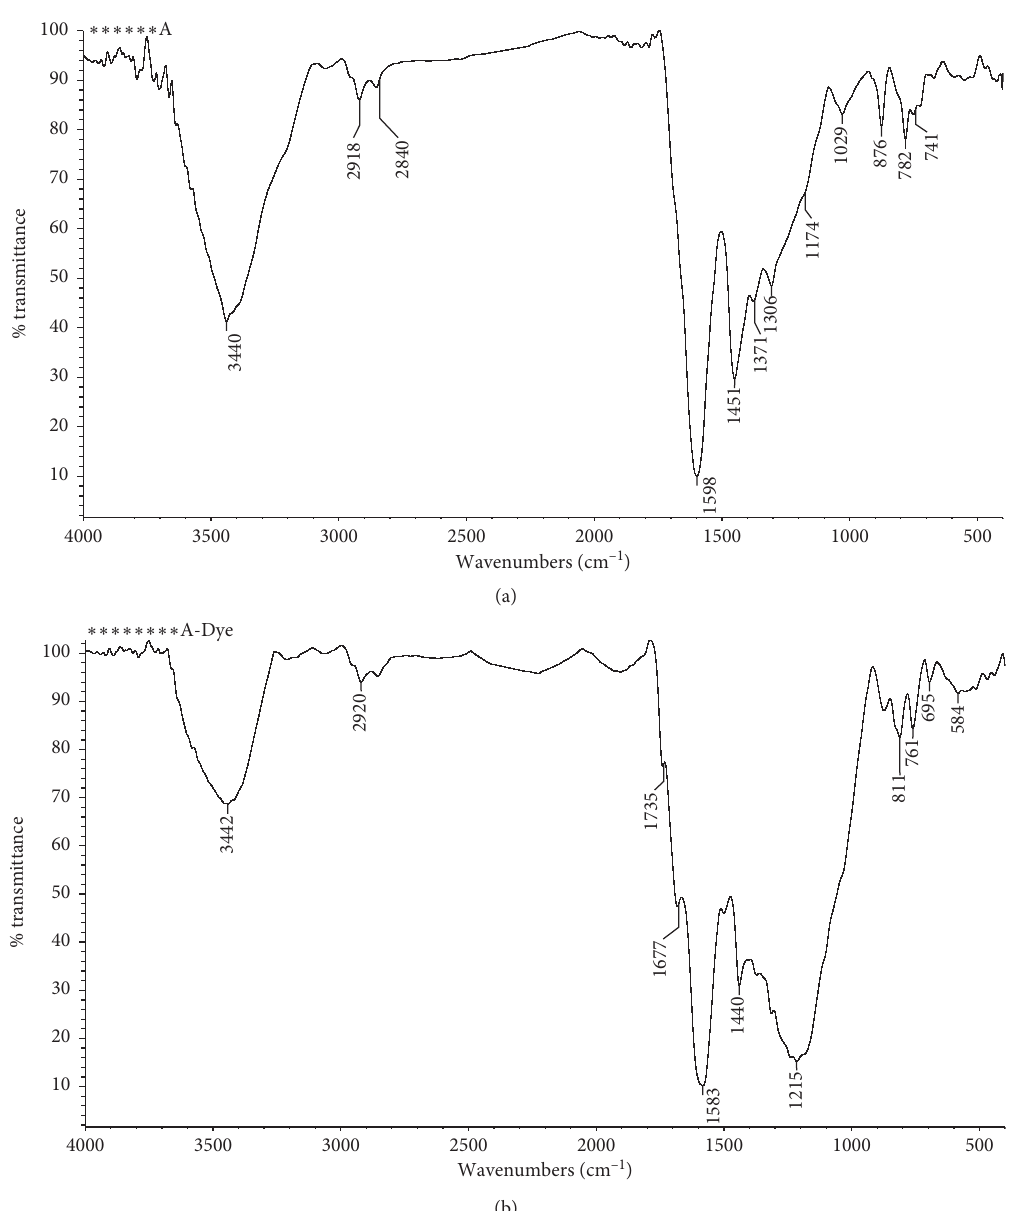
Figure 2: FTIR for (a) activated carbon and (b) activated carbon with brilliant green